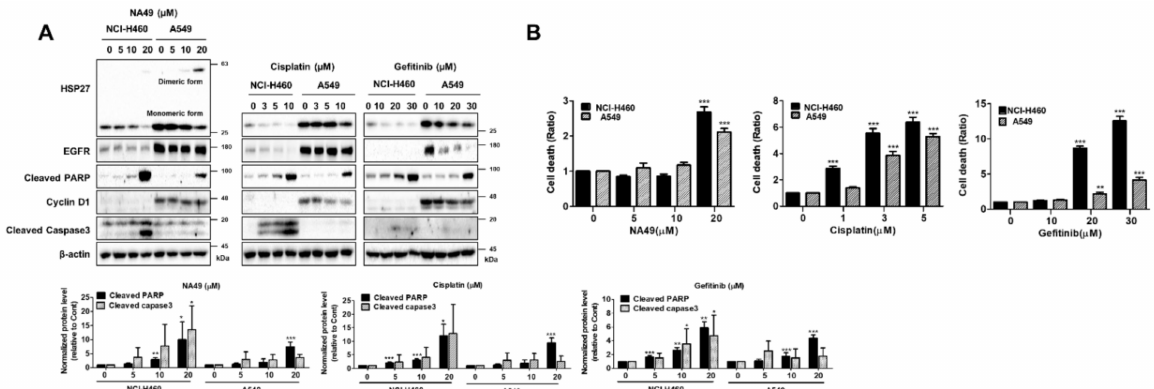
Figure 3. HSP27 cross-linking activities of NA49 and effect of cisplatin or gefitinib in EGFR wild-type lung cancer cell lines. ( A ) NCI-H460 and A549 cells were treated with NA49 (0, 5, 10, and 20 µ M), cisplatin (0, 3, 5, and 10 µ M), or gefitinib (0, 10, 20, and 30 µ M) for 24 h, and cell lysates were detected by Western blot analysis. Protein levels were quantified using Image J software. The data were expressed as the fold change relative to the control and normalized to β -actin in graph. ( B ) NCI-H460 and A549 cells were treated with NA49 (0, 5, 10, and 20 µ M), cisplatin (0, 3, 5, and 10 µ M), or gefitinib (0, 10, 20, and 30 µ M) for 48 h, and cell death was analyzed by flow cytometry after treatment with propidium iodide (PI). Results are the mean and standard deviation of three independent experiments (* p < 0.05, ** p < 0.01, *** p < 0.001 vs. untreated control cells.).